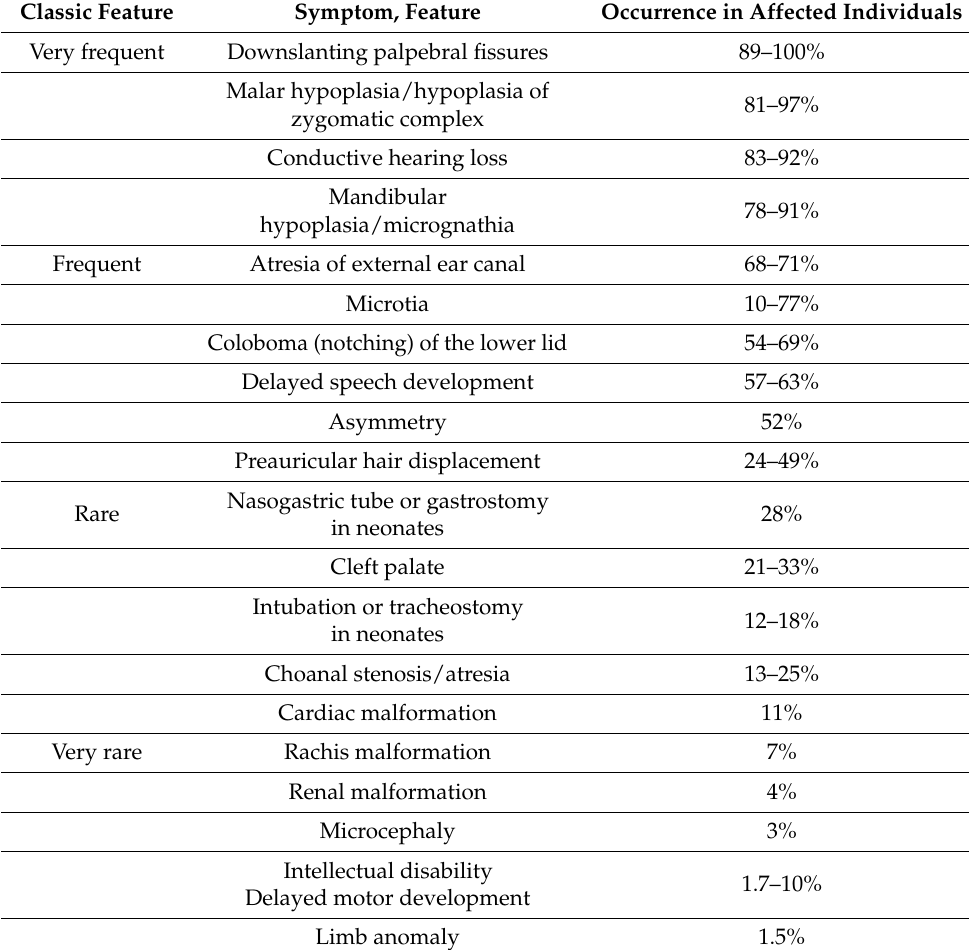
Table 2. Classic features of Treacher Collins